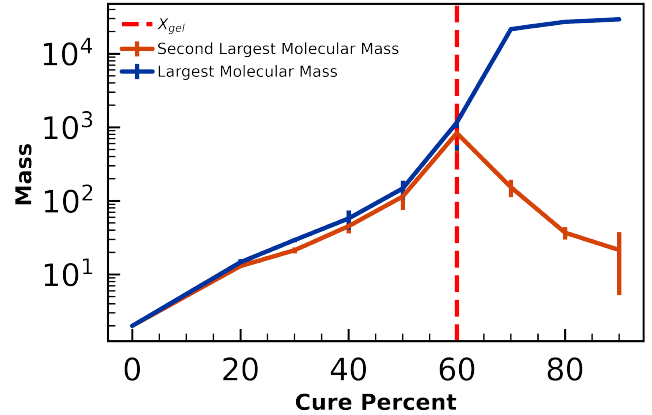
Figure 5. Divergence of the largest (blue) and second-largest (orange) molecular mass indicates gelation, here calculated at α = 60%, in agreement with theory (58%) and experiments (60%). Error bars denote standard deviations of 3 independent samples, except the 90% cure case, which have 2